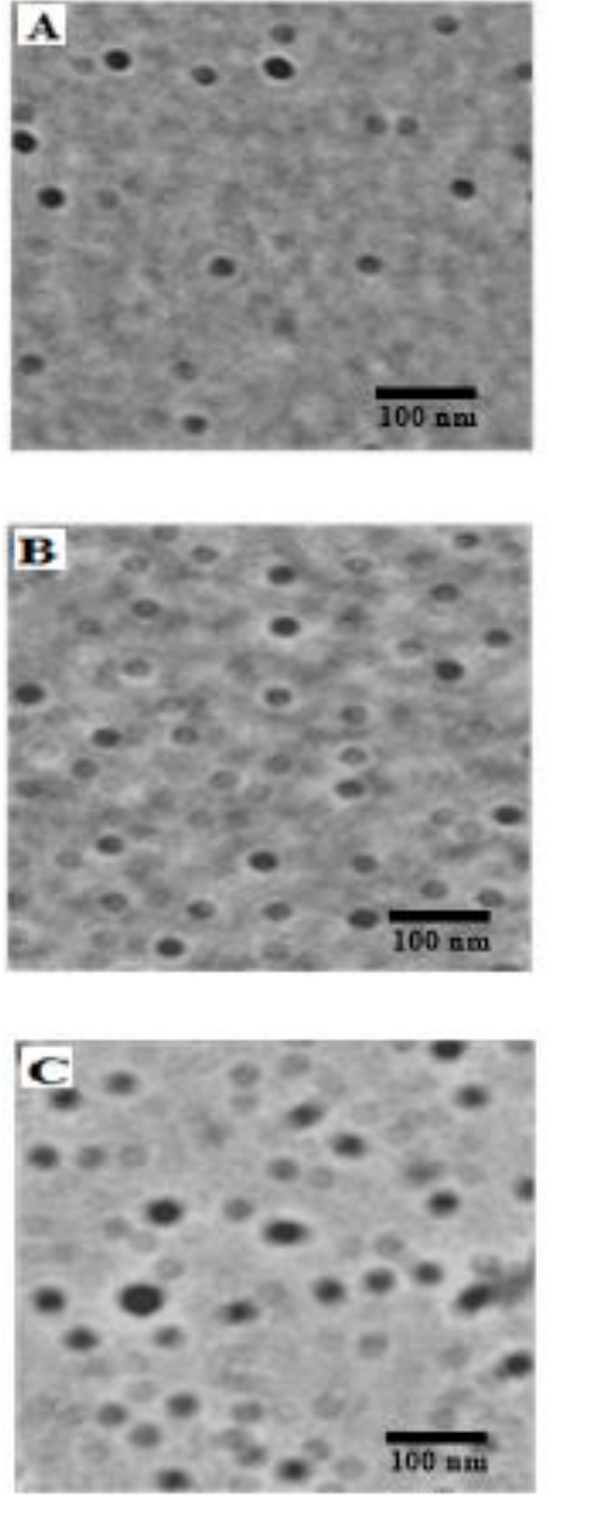
Figure 4. TEM ( left ) and AFM phase scan ( right ) for randomly grafted arborescent copolymers: ( A ) G2PBG 15 - g -PEO, ( B ) G2PBG 29 - g -PEO, and ( C ) G2PBG 65 - g -PEO.